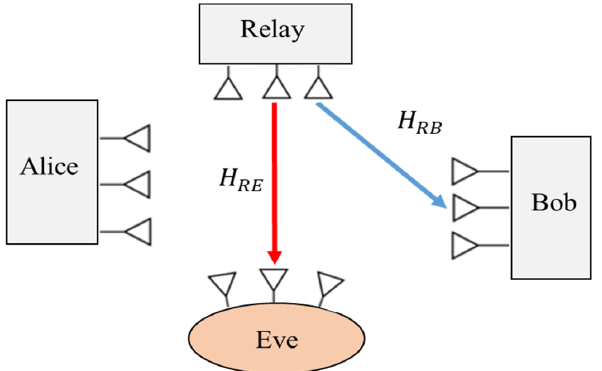
Figure 7. A system model for a wiretap relay channel in the second time slot.